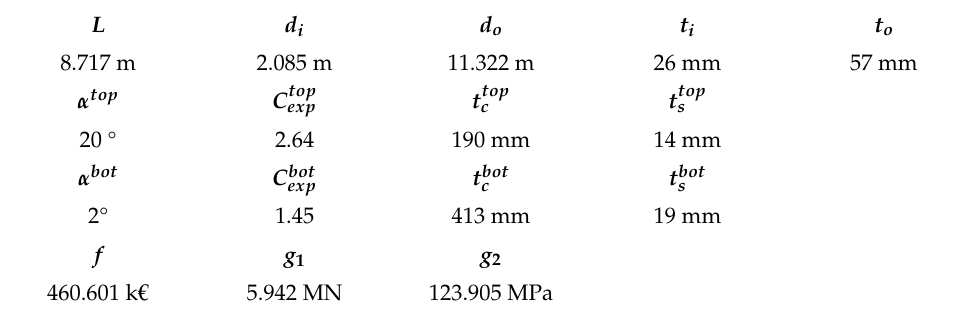
Figure 10. Evolution of the cost of the UBB during the optimization process with the CMNGA. Table 8. Design variables, cost and constraint values of the optimized UBB with the